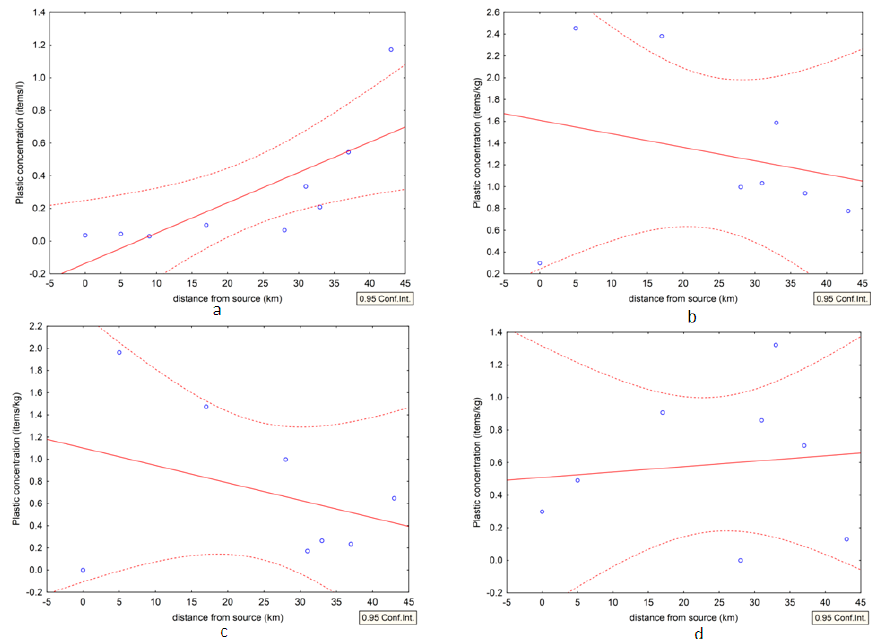
Figure 7. Scatter plot of the distance from the river source in each station and the concentration of plastics in: ( a ) water, ( b ) total sediments, ( c ) sediments of the riverbed and ( d ) sediments of the riverbanks. Dotted lines indicate the confidence interval, the continuous line indicate the regression line.